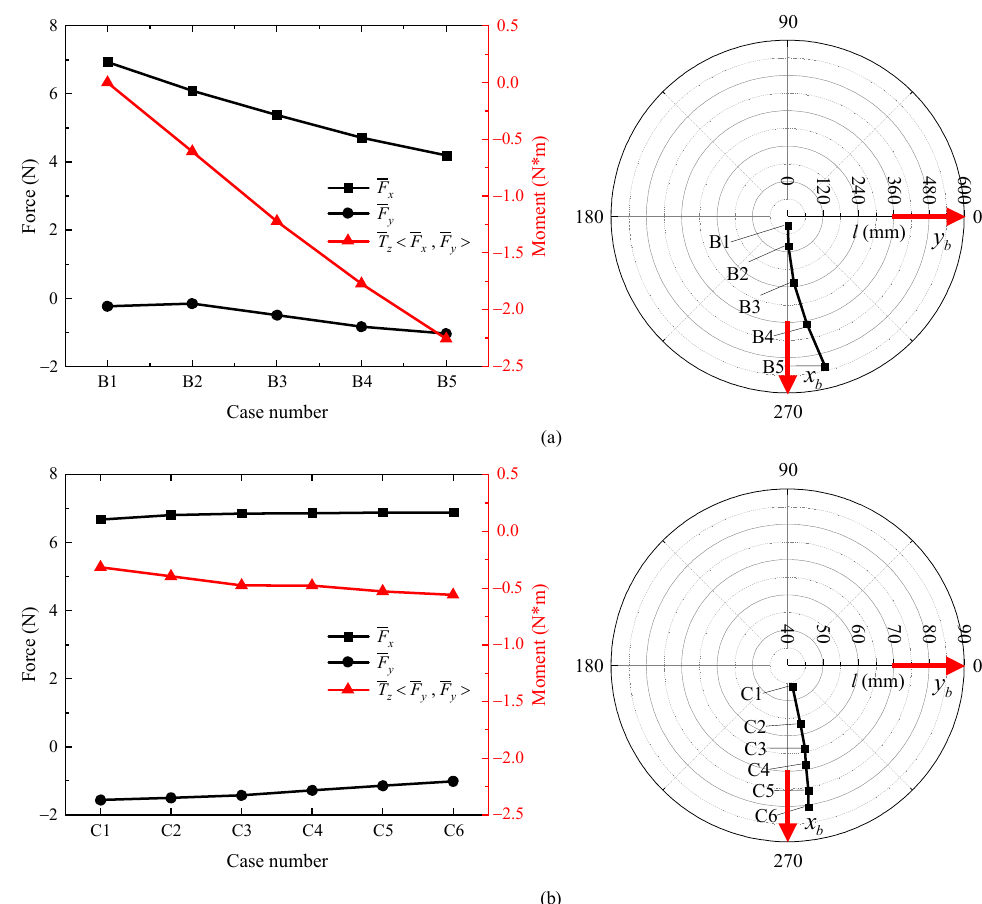
Figure 12. Hydrodynamic performance and equivalent point variation in turning torque. ( a ) Experimental results of Case B. ( b ) Experiment results of Case C.